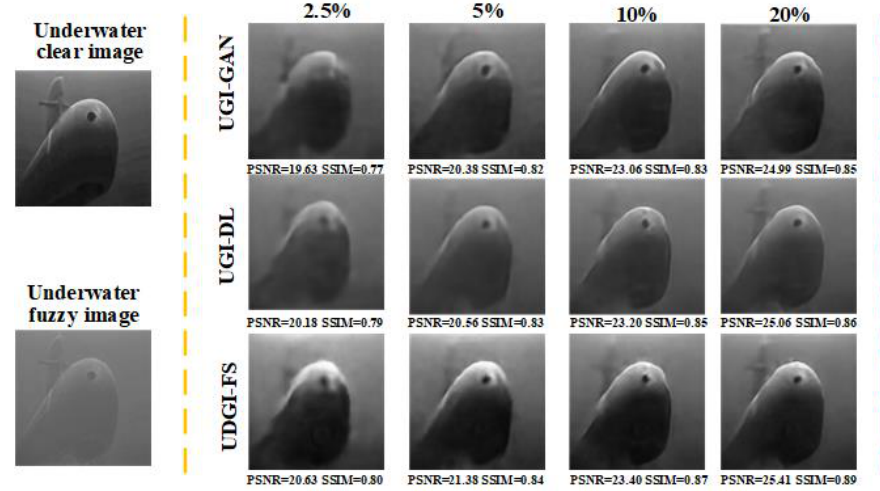
Figure 12. Comparison of reconstructed submarine images of UDGI-FS, UGI-DL, and UGI-GAN at different sampling rates.